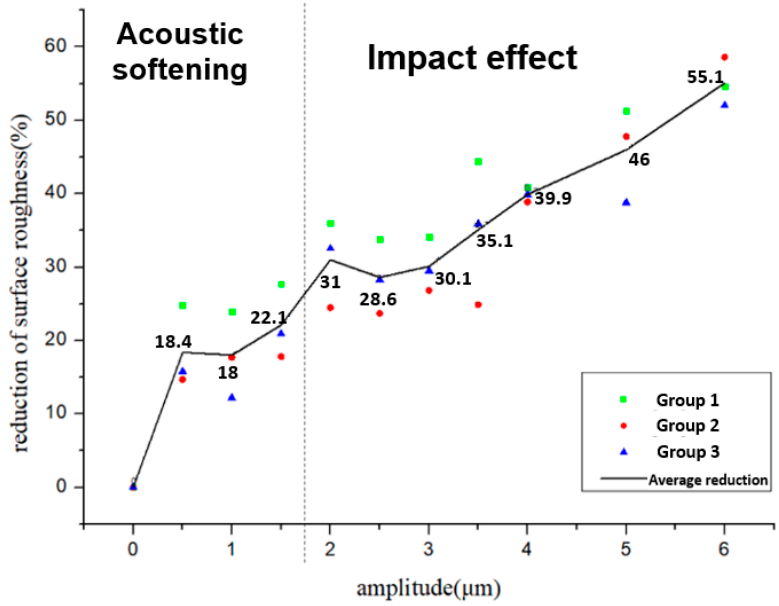
Figure 11. The reduction in the surface roughness–amplitude curve.